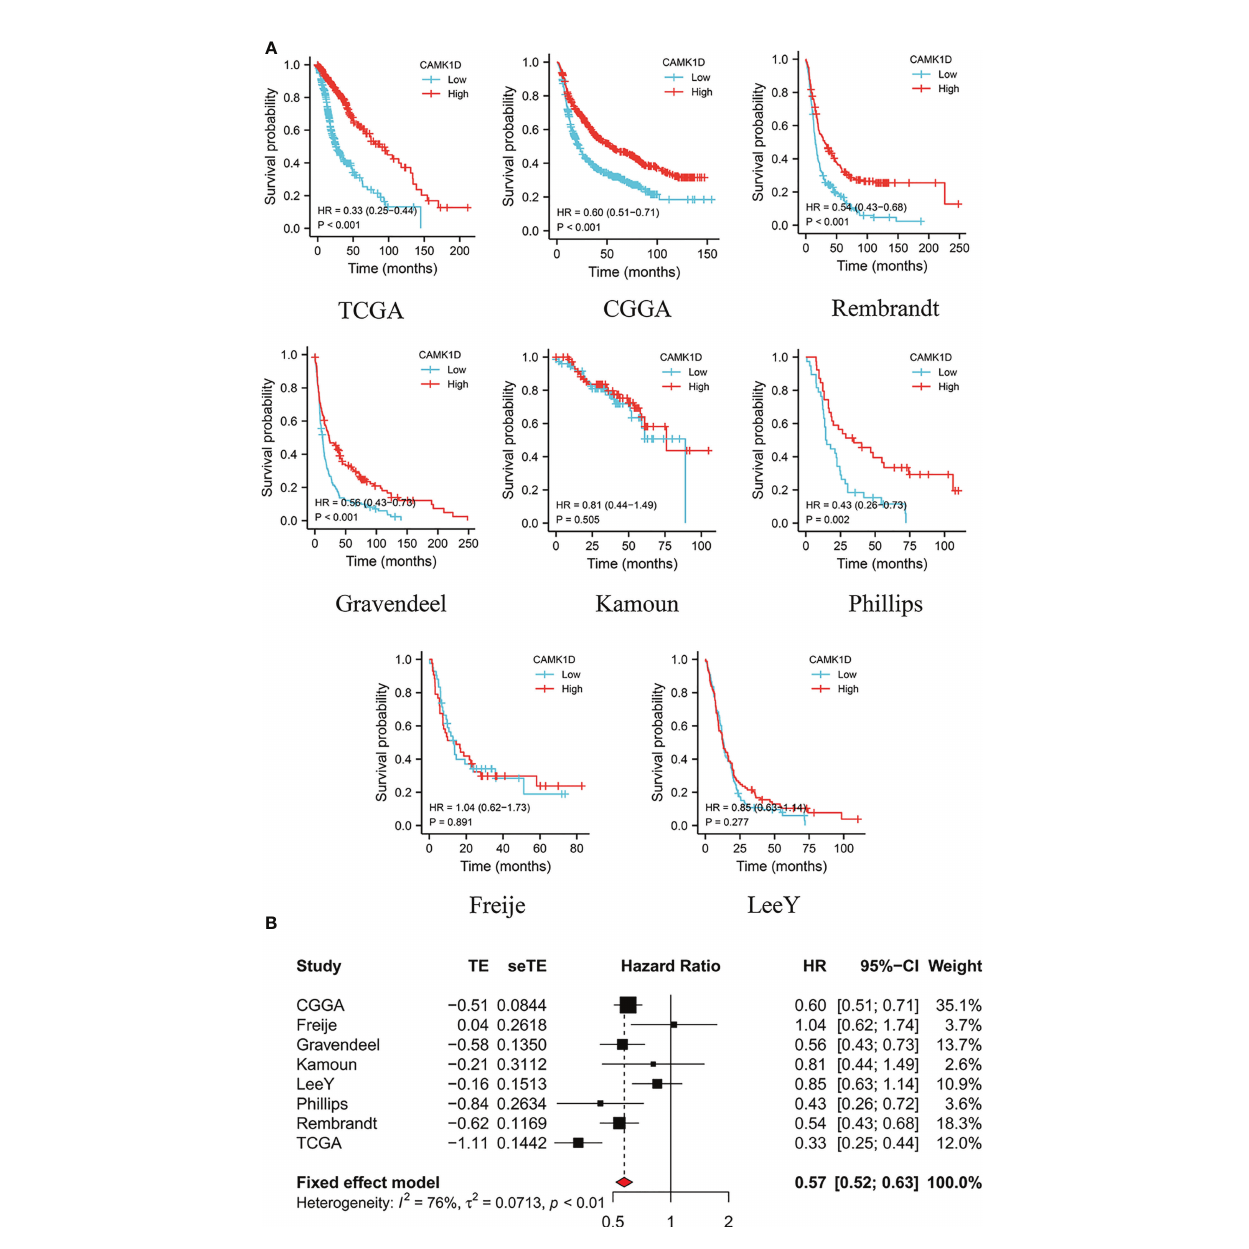
FIGURE 2 | Decreased expression of CAMK1D predicts short survival time of glioma patients. (A) Survival curves of CAMK1D in various datasets of glioma showing that glioma patients with lower expression level of CAMK1D have shorter survival time than patients with higher expression levels. (B) The forest plot was presented in the RRs for glioma patients with high expression of CAMK1D compared to low